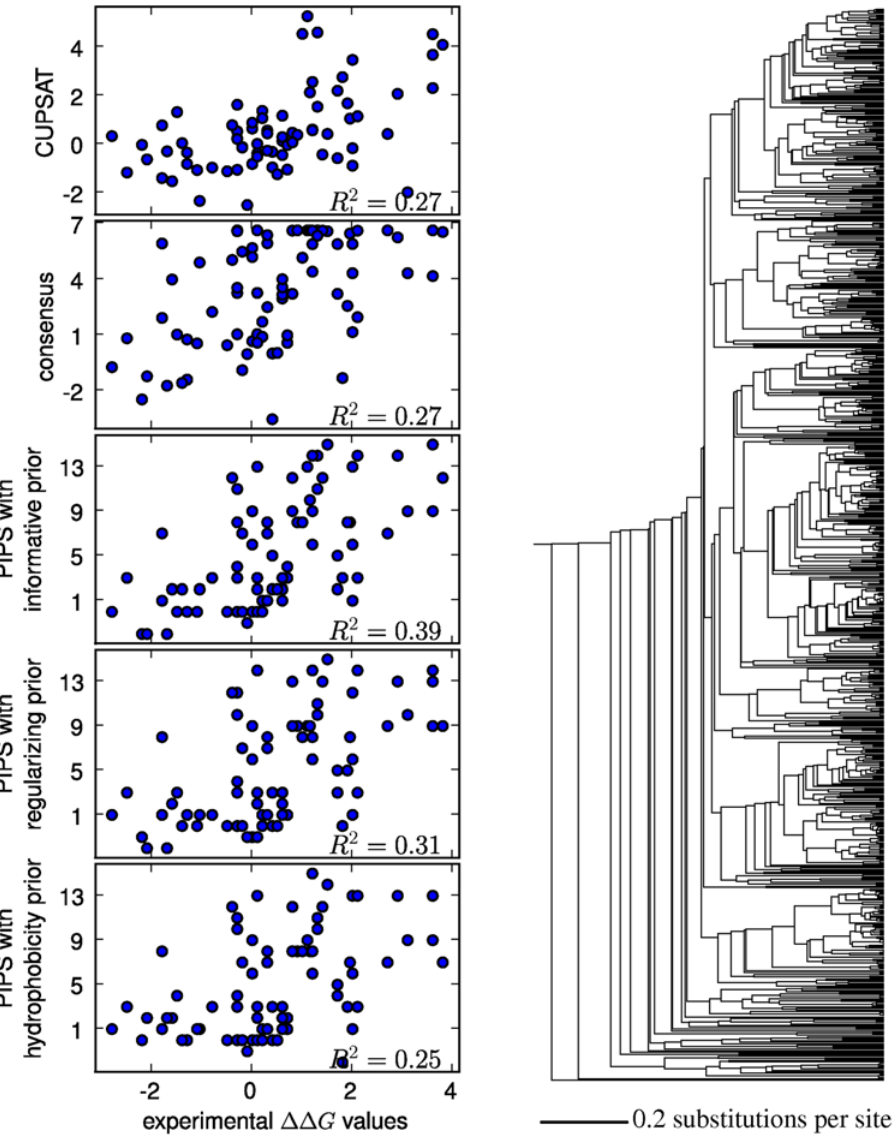
Figure 5. Experimentally measured and predicted DD G values for the 68-residue cold shock protein. The plots at left show the predictions made by the CUPSAT physicochemical modeling program, the consensus approach, and the PIPS phylogenetic inference program using the informative, regularizing, and hydrophobicity priors. To the right is the phylogenetic tree of 763 sequences that was utilized by the PIPS program. The R 2 values are the squared Pearson correlation